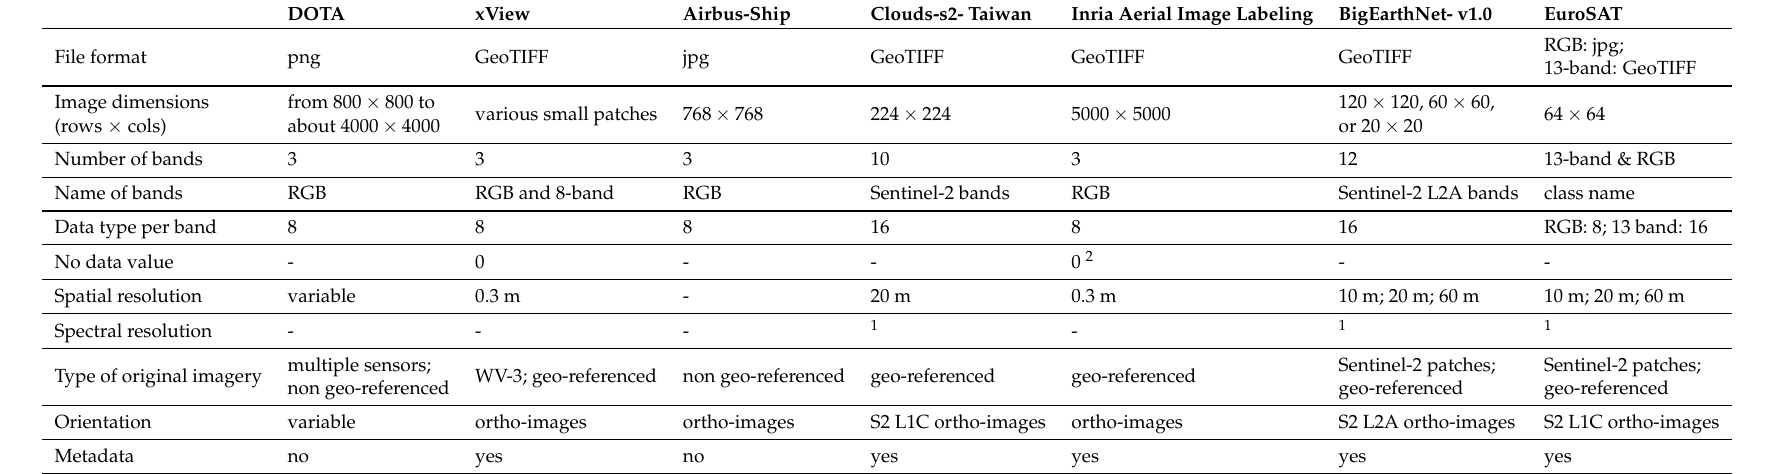
Table 3. Intrinsic image